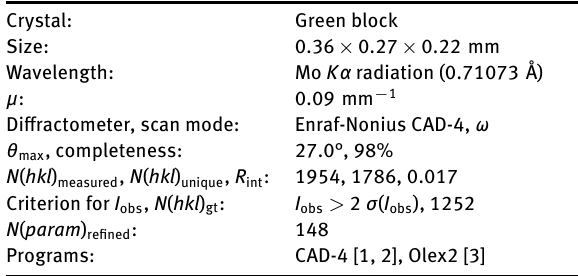
Table 2: Fractional atomic coordinates and isotropic or